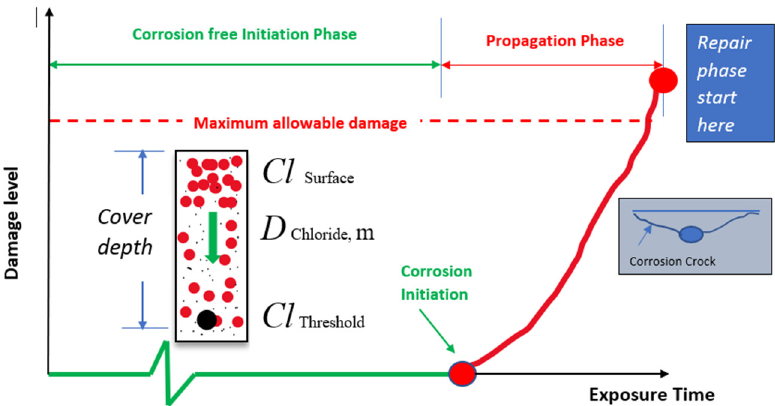
Figure 4. Estimation of service life of concrete in response to chloride-induced corrosion. Note: Cl th —critical chloride threshold; Cl—chloride surface concentration; m—ageing coe ffi cient; and D—di ff usion coe ffi cient